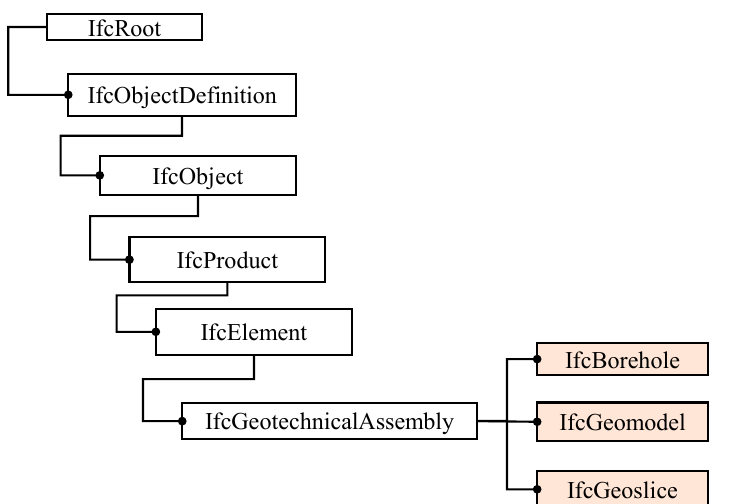
Figure 3. Abstract supertype for geotechnical entities used in the study for the geotechnical property representation in BIM.